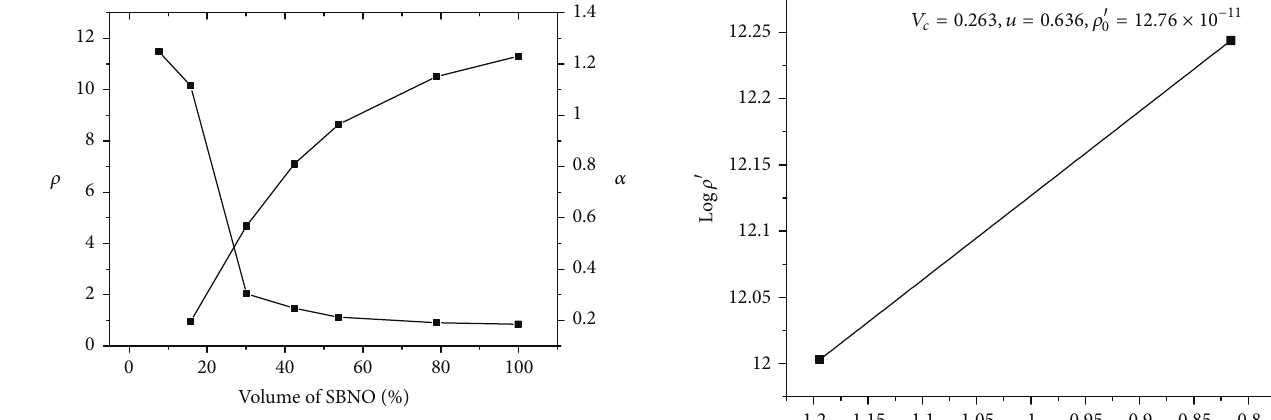
Figure 6: Variation of normal state resistivity and temperature coefficient of resistivity for different vol% of SBNO.